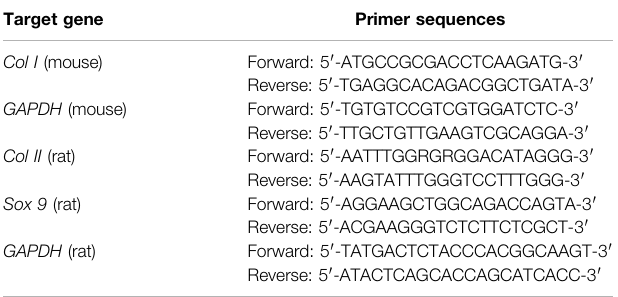
TABLE 1 | Primer of